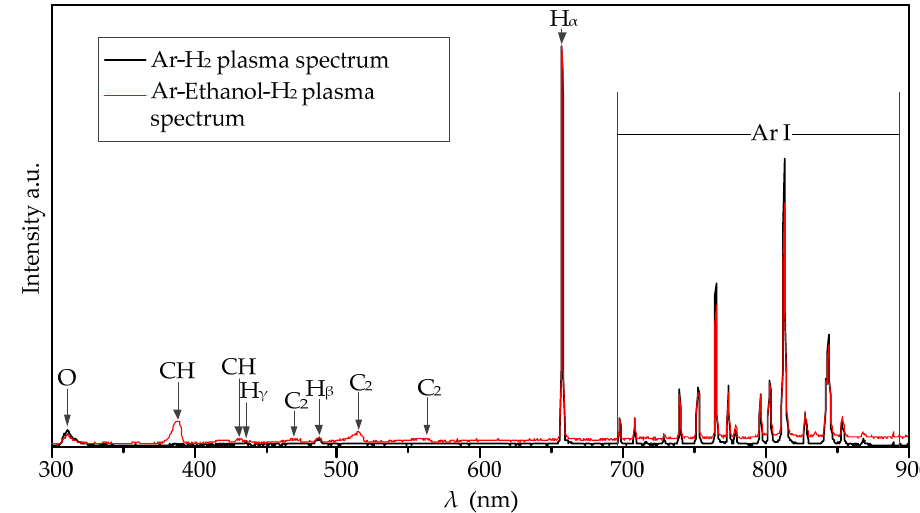
Figure 2. The measured spectrums of Ar-H 2 and Ar-ethanol-H 2 microwave plasma in atmospheric pressure.